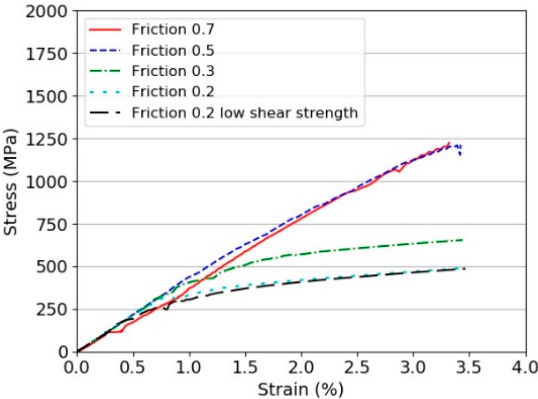
Figure 16. Virtual tensile testing of a Dyneema ® HB26 laminate specimen (thickness 10 mm) with different static and dynamic frictional coefficients.